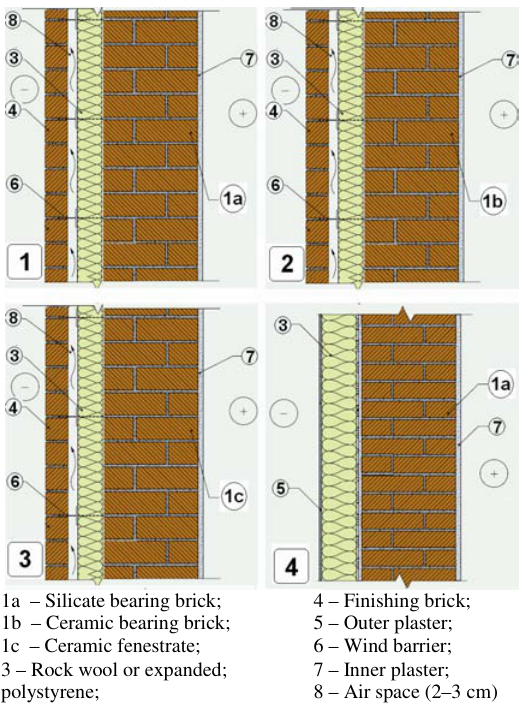
Fig. 3. Alternatives of multi-layered external walls